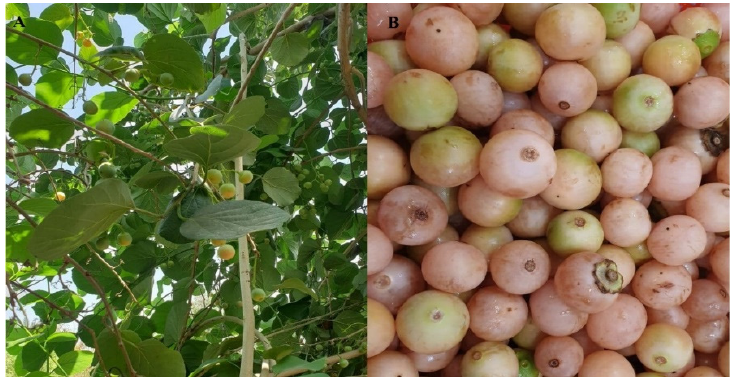
Figure 9. Images represent Cordia myxa tree ( A ) and its fruits ( B ).